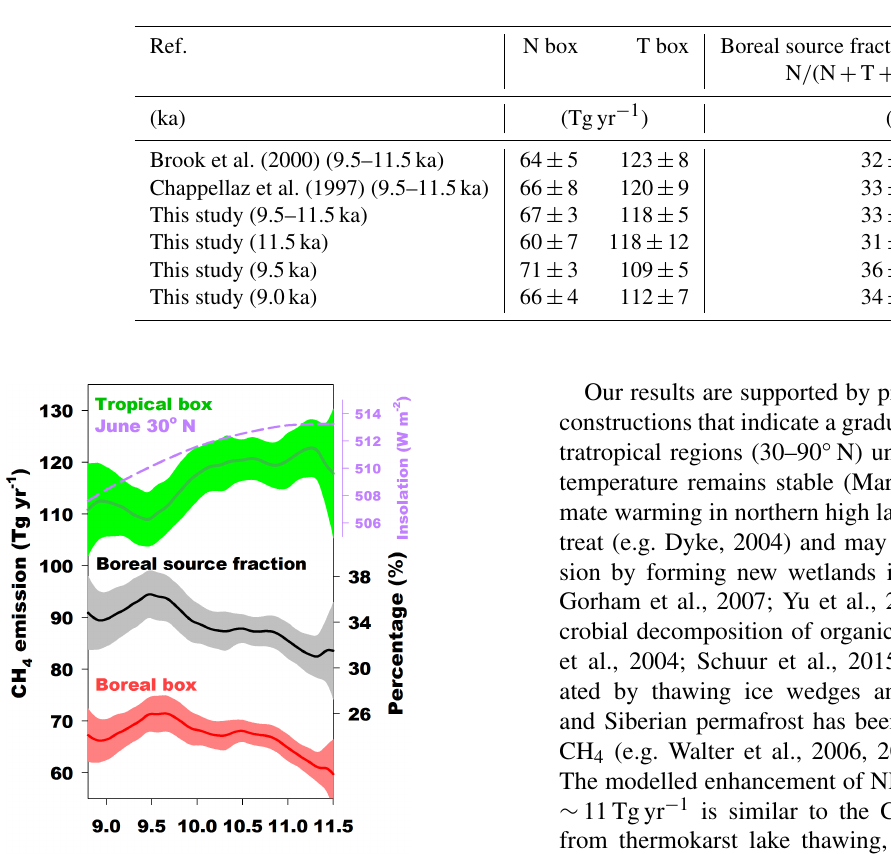
Table 2. Results of the three-box source distribution model from the combined IPD showing emissions of tropical (green, T) and boreal (red, N) boxes and boreal source fraction (N / (T + N + S)) at specific time slices. Also shown are previous estimates for comparison. Errors denote 95% confidence interval. The uncertainty for the 9.5–11.5ka period is the average of 95% confidence interval of the low-pass-filtered reconstruction of each box emission.